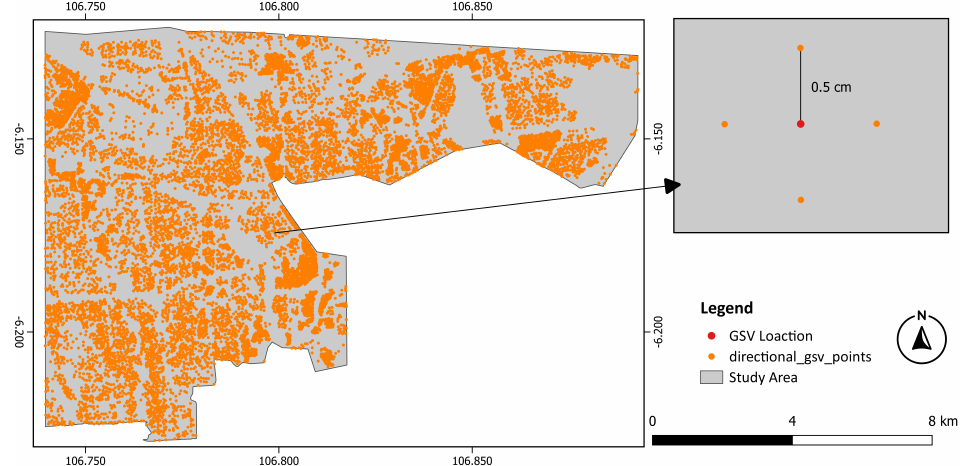
Figure 7. At a distance of 0.5 cm from each GSV location, additional points were created in the cardinal direction (red are GSV locations and yellow are newly generated points).